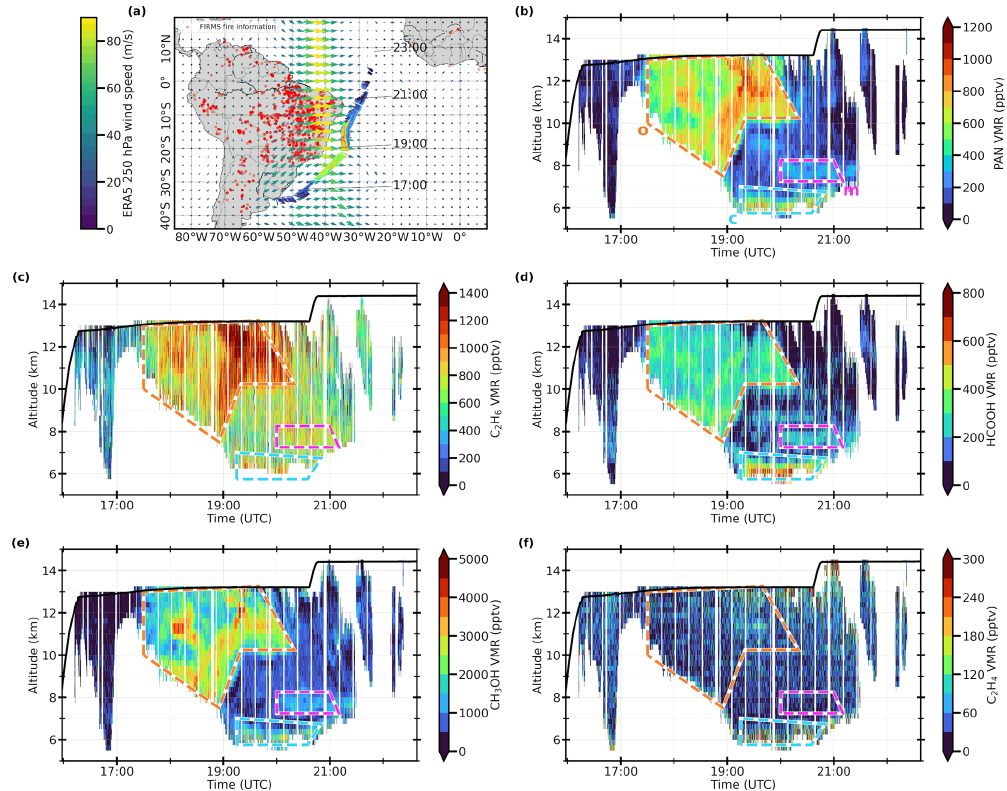
Figure 2. Same as Fig. 1, but for SouthTRAC flight on 7 October 2019 from Buenos Aires, Argentina, to Sal, Cabo Verde. In panel (a) , ERA5 winds are displayed at 19:00UTC. Note that color bars may have changed compared to Fig.